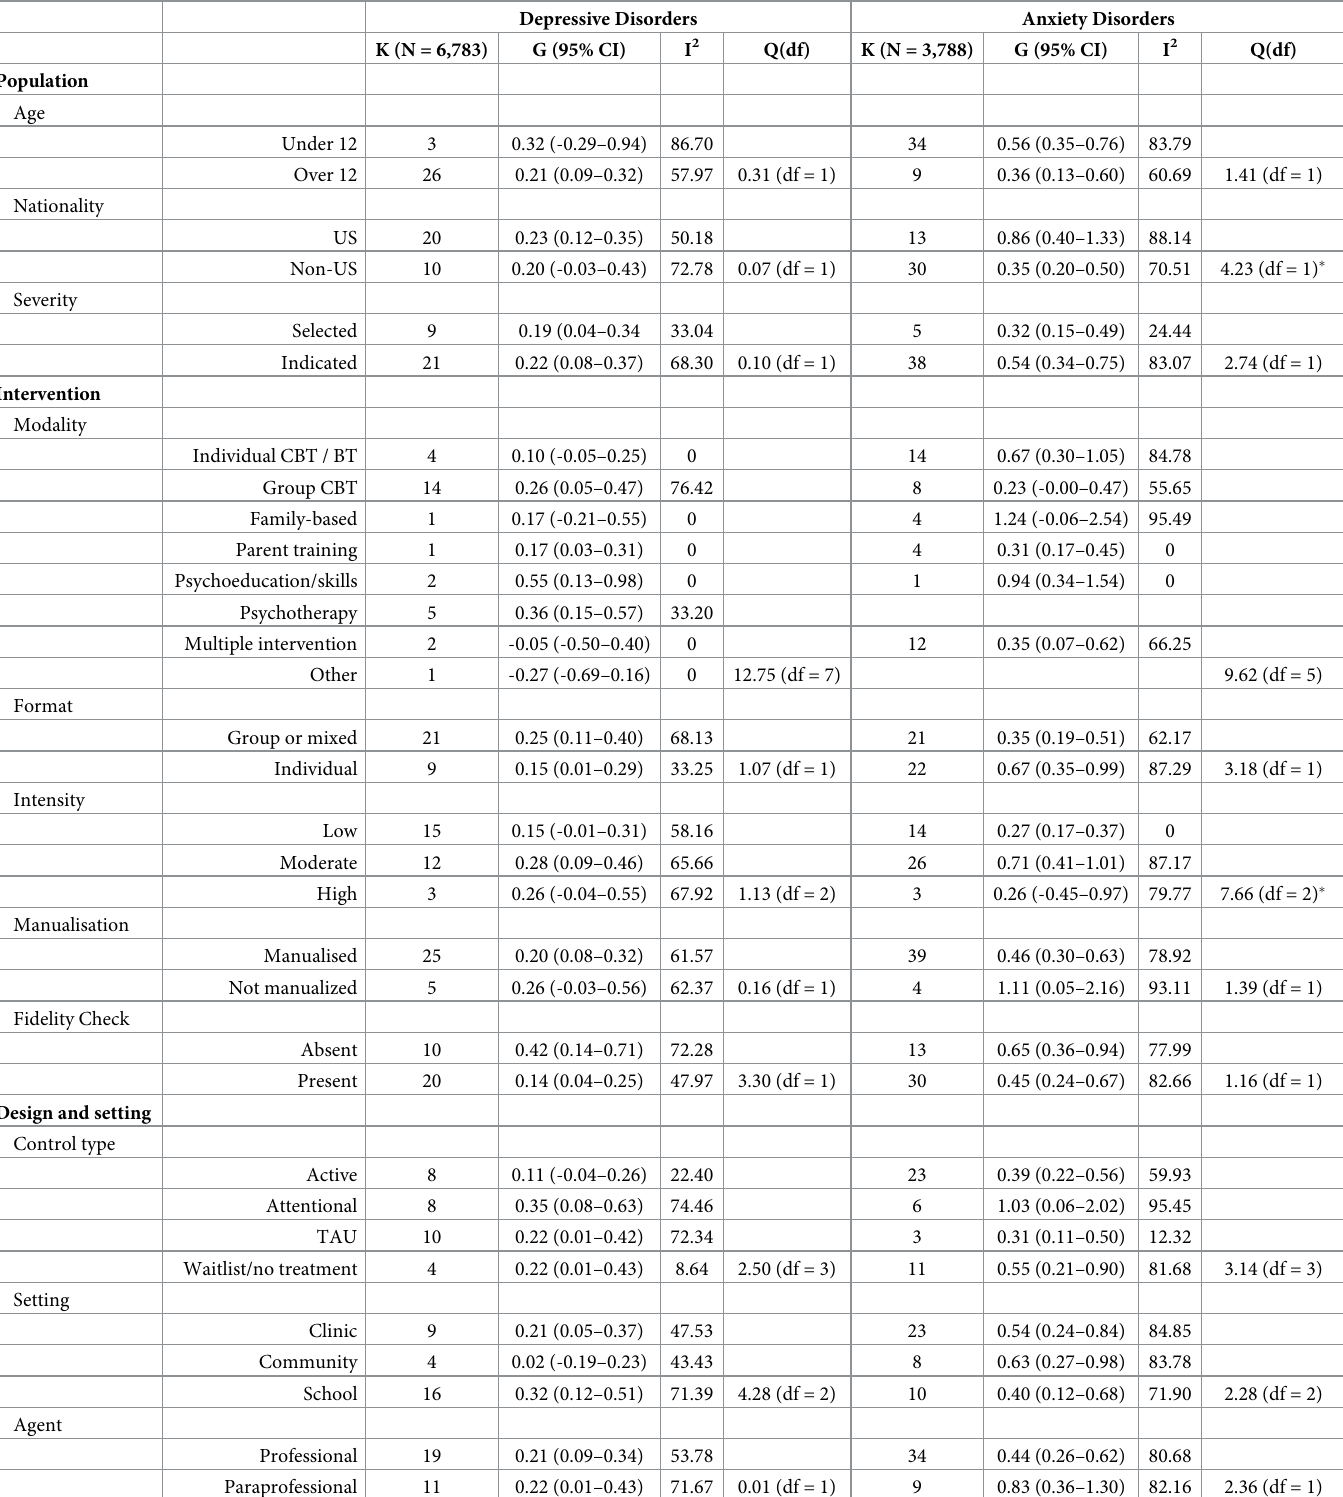
Table 4. Subgroup analysis at follow-up for depressive and anxiety